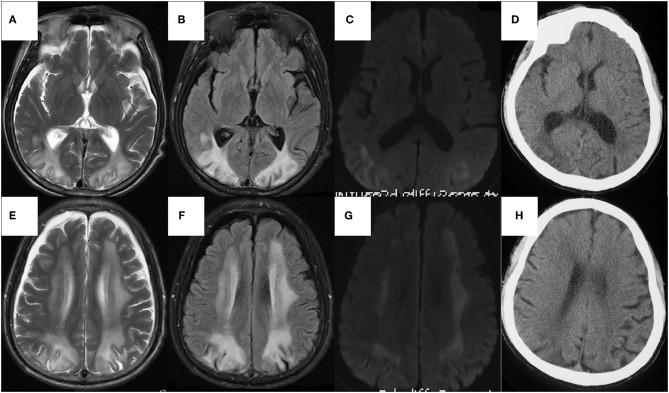
The axial sequences on head MRI of the patient (A–F) and The head CT of the sick brother (G,H). (A–F) Bilateral symmetric diffuse white matter hyperintensity, predominantly involving the frontal, parietal, occipital, and periventricular regions on T2WI (A,B) and FLAIR (C,D), with restriction in peripheral areas of lesions on DWI (E,F), whereas normal on ADC map. The U-fibers of bilateral occipital lobe and the white matter of paracortical, subcortical were involved but corpus callosum and internal capsule were relatively reserved. There was atrophy in temporal and frontal lobes, especially significant in frontal pole. (G,H) The low-density lesions around bilateral ventricles mainly involving white matter around the posterior horn of lateral ventricles, with atrophy of temporal and frontal lobes especially in frontal pole.